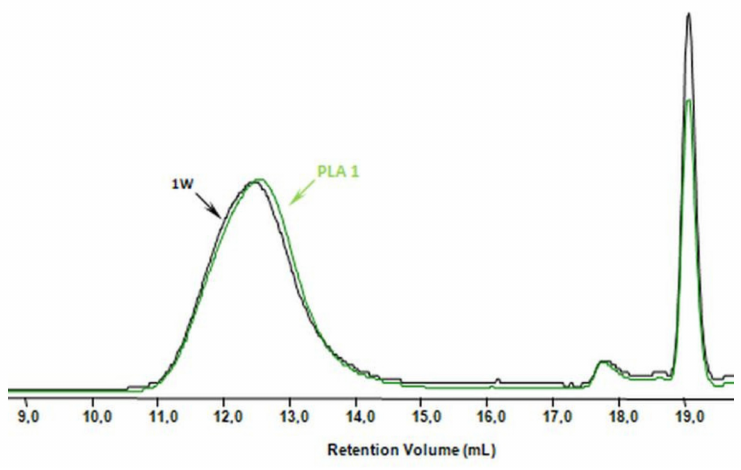
Figure 2. GPC traces of sample PLA 1 before and after welding